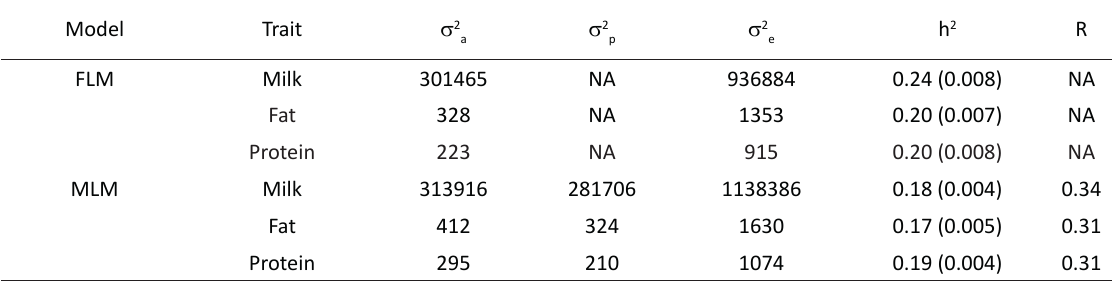
), permanent environment ( σ 2 a